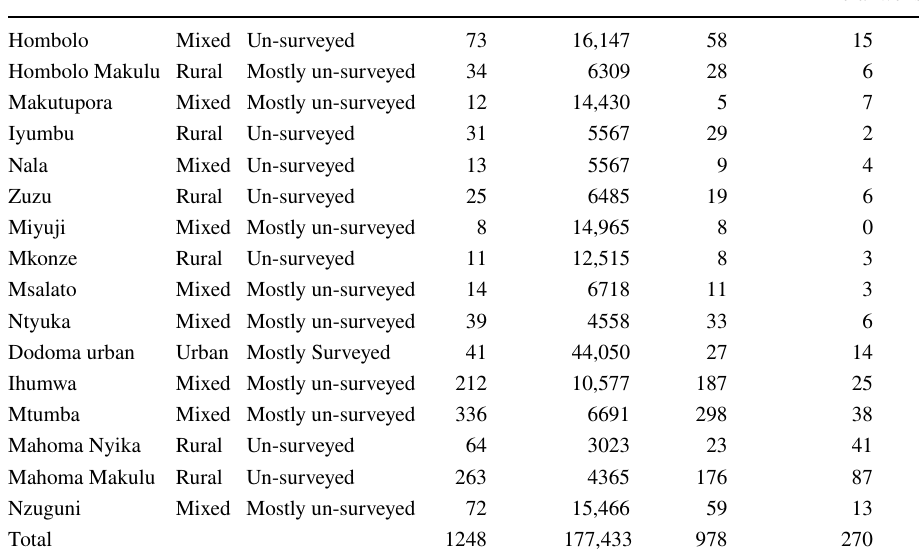
Table 1 SDWs distribution and characteristics based on FOs, FGDs and, URT (2013,